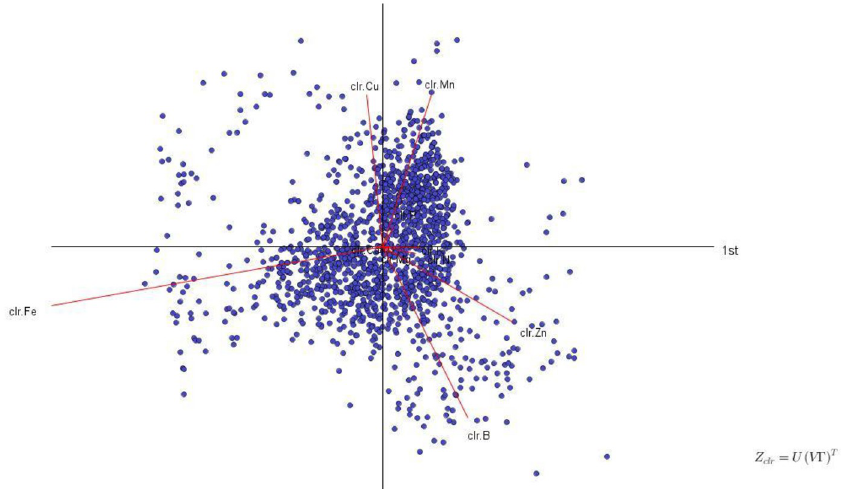
Fig 1. Biplot analysis of the Quebec-Wisconsin dataset.